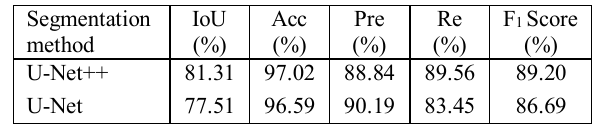
Table 1 . Performance evaluation of segmentation models.